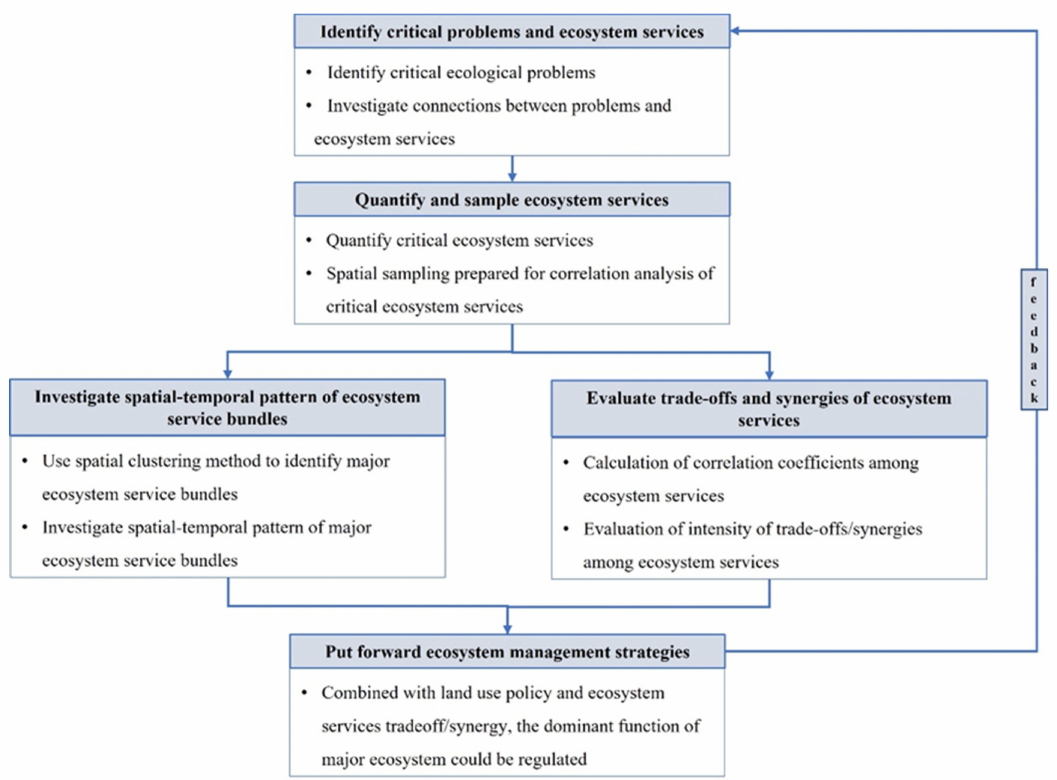
Figure 2. Framework of ecosystem service bundle identification for ecosystem services trade-off and synergy